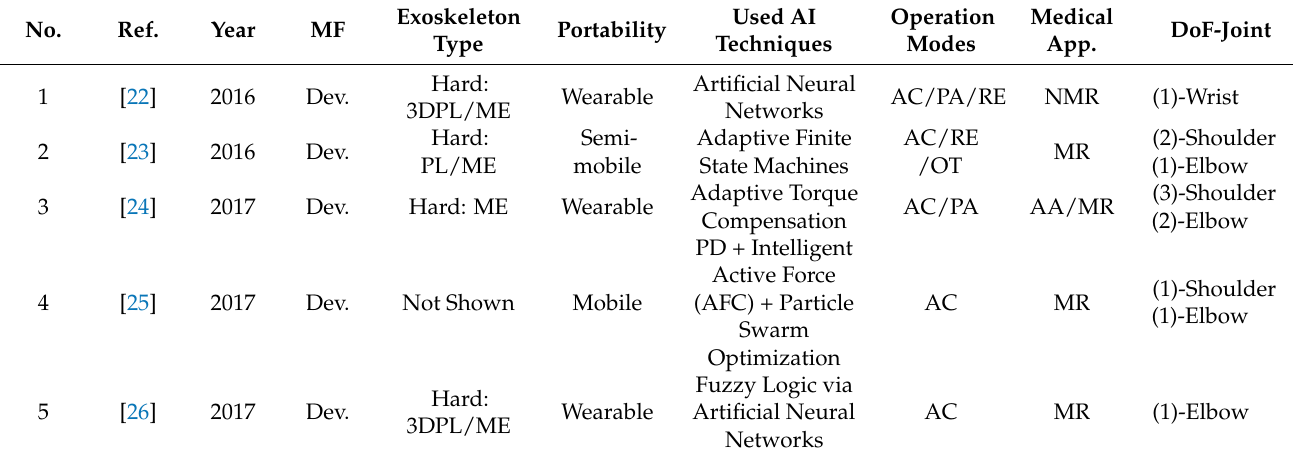
Table 2. General summary of the main characteristics of the studies included in the review. No.